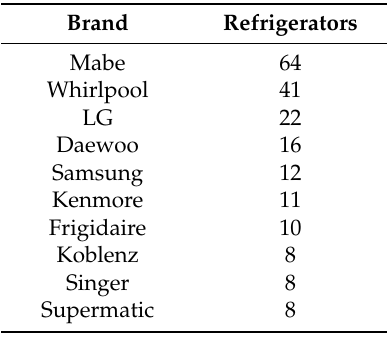
Table 2. Most popular refrigerator brands in the surveyed homes.